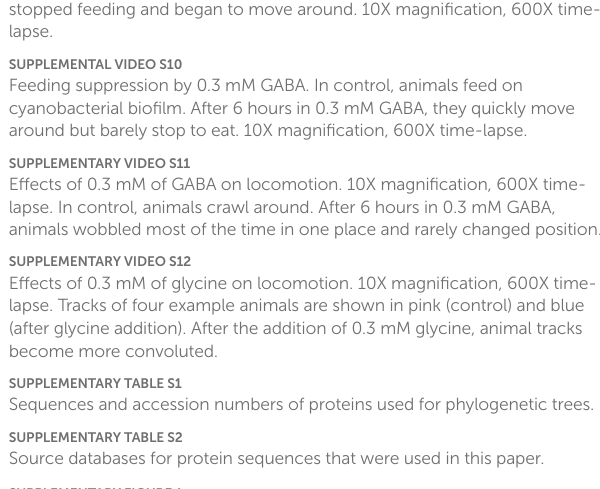
SUPPLEMENTARY TABLE S1 Sequences and accession numbers of proteins used for phylogenetic trees. SUPPLEMENTARY TABLE S2 Source databases for protein sequences that were used in this paper. SUPPLEMENTARY FIGURE 1 Effects of GABA on the locomotion of Trichoplax on a conditioned dish. (A) Animal locomotion on a clean dish is increased over time in control but slightly decreases during incubation with 0.3 or 1 mM GABA. Asterisks denote a significant difference in speed from the control (Welch t -test, *** - p < 0.001). N animals = 98, 50, 74, 29, 46, 69, 35, 44, and 72, respectively. (B) . Track straightness on a clean dish does not change over time in control but decreases during incubation with GABA (tracks become more convoluted). N animals are the same as in A. SUPPLEMENTARY FIGURE 2 Comparison of feeding dynamics on green algae Tetraselmis and cyanobacteria Oscillatoria . After 12 hours, feeding on cyanobacteria is less active than on green algae, and the standard deviation of feeding activity is higher on cyanobacteria. N animals = 40 for green algae and 48 for cyanobacteria. SUPPLEMENTARY FIGURE 3 Bayesian phylogenetic tree of ionotropic glutamate receptors. Numbers denote bayesian posterior probability near nodes. Analysis was run for 1.42 million generations, and convergence was checked with Tracer. Sequences were aligned using E-INS-i algorithm implemented in MAFFT online. Alignment consisted of 4071 positions, 1464 of them parsimony- informative. SUPPLEMENTARY FIGURE 4 Maximum Likelihood phylogenetic tree of metabotropic glutamate and related receptors. Numbers denote ultrafast bootstrap support near nodes. Sequences were aligned using E-INS-i algorithm implemented in MAFFT online. Alignment consisted of 4071 positions, 1464 of them parsimony- informative. SUPPLEMENTARY FIGURE 5 Maximum Likelihood phylogenetic tree of metabotropic GABA receptors. Numbers denote ultrafast bootstrap support near nodes. Sequences were aligned using E-INS-i algorithm implemented in MAFFT online. Alignment consisted of 5312 positions, 1376 of them parsimony-informative. SUPPLEMENTARY FIGURE 6 Bayesian phylogenetic tree of vesicular glutamate and related transporters (SLC17 family). Numbers denote bayesian posterior probability near nodes. Analysis was run for 10 million generations, and convergence was checked with Tracer. Sequences were aligned using E-INS-i algorithm implemented in MAFFT online. Alignment consisted of 1036 positions, 603 of them